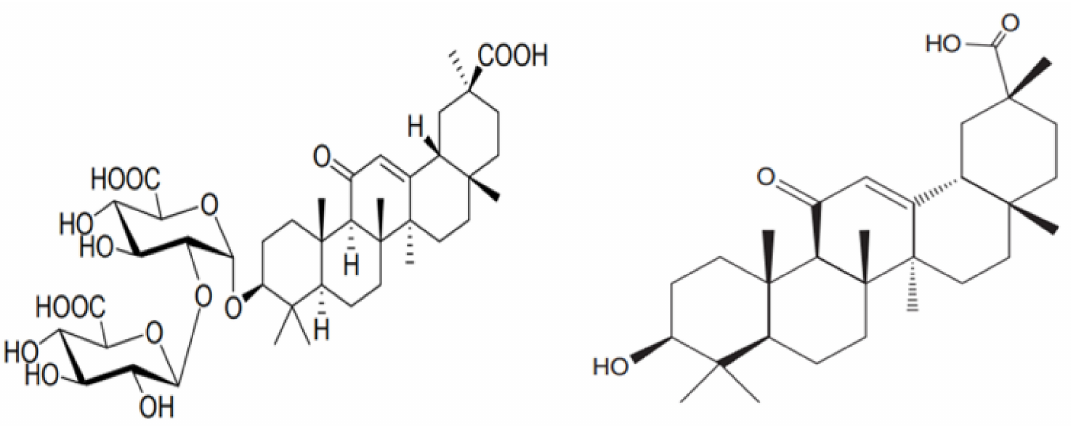
Figure 3. Chemical structure of Glycyrrhizic Acid (GL) ( left ) and 18 β -Glycerrhitinic acid (GA) ( right